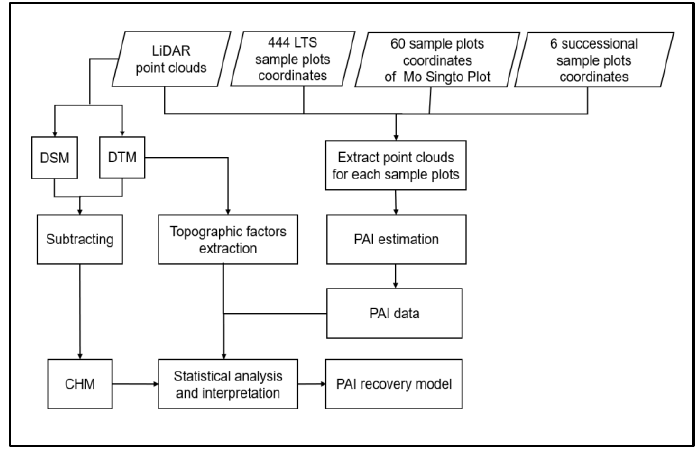
Figure 2. Overall methodology.